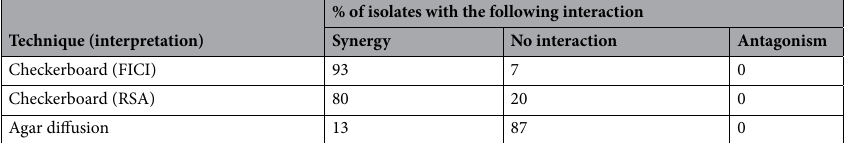
Table 2. Summary of interactions of isavuconazole with colistin against 15 Candida auris isolates by checkerboard and interpretation by fractional inhibitory concentration index, response surface analysis and by agar diffusion. FICI, fractional inhibitory concentration index; RSA, response surface